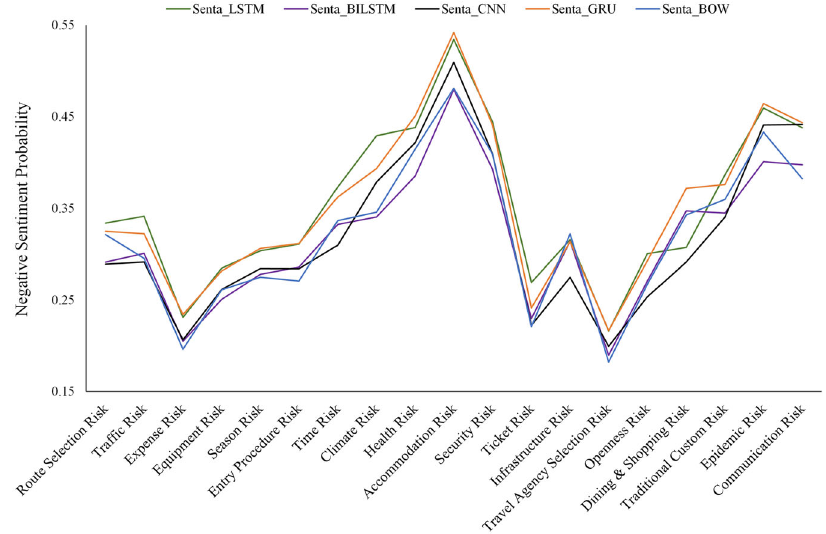
Fig. 6 The negative sentiment probability of post-travel perceived risks. Negative sentiment probabilities for each type of risk obtained from the fi ve sentiment analysis